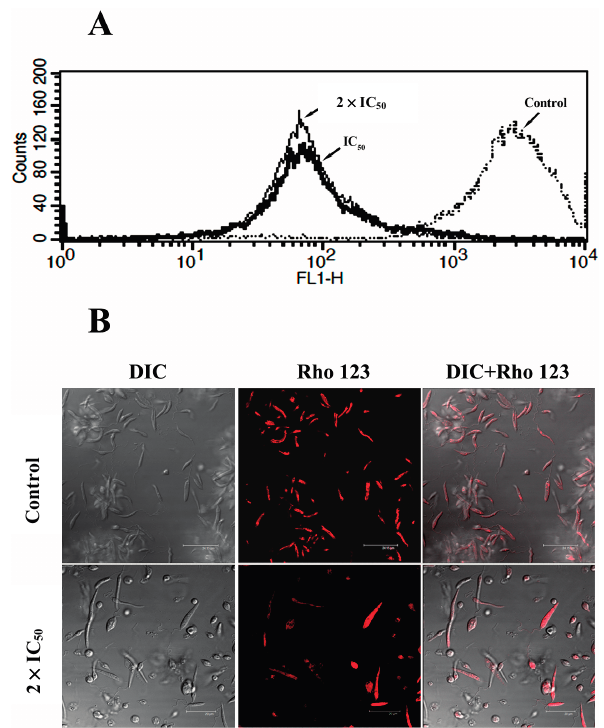
Figure 6. The Effects of DME on the mitochondrial membrane potential of L. amazonensis promastigotes. ( A ) Flow cytometry overlay histograms of the controls and DME-treated cells and stained with Rho 123. ( B ) Confocal image of the control and treated-cells. All control cells presented intense Rho123 labeling and preserved morphology. Cells treated with 2 × IC displaying a vanished fluorescence and drastic morphological 50